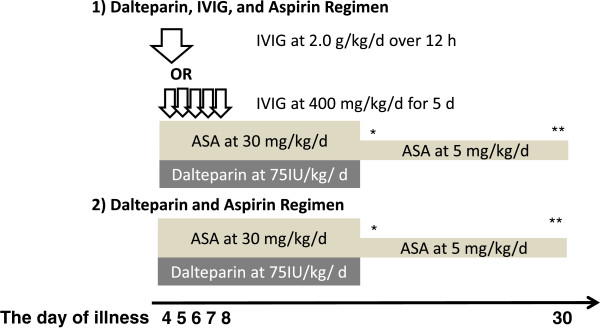
The two regimens of dalteparin combination therapy. *Aspirin (ASA) was decreased to 5 mg/kg/day if the patient was afebrile, clinically improving, and/or showed a CRP < 1.0 mg/dL. **Aspirin withdrawn after 1 month of illness unless there were cardiac sequelae. Dalteparin was administered until the patient was afebrile, clinically improving, and/or showed a CRP < 1.0 mg/dL. ***IVIG started on day 4 or 5 of illness (the first illness day was defined as the day of onset of fever >38°C).